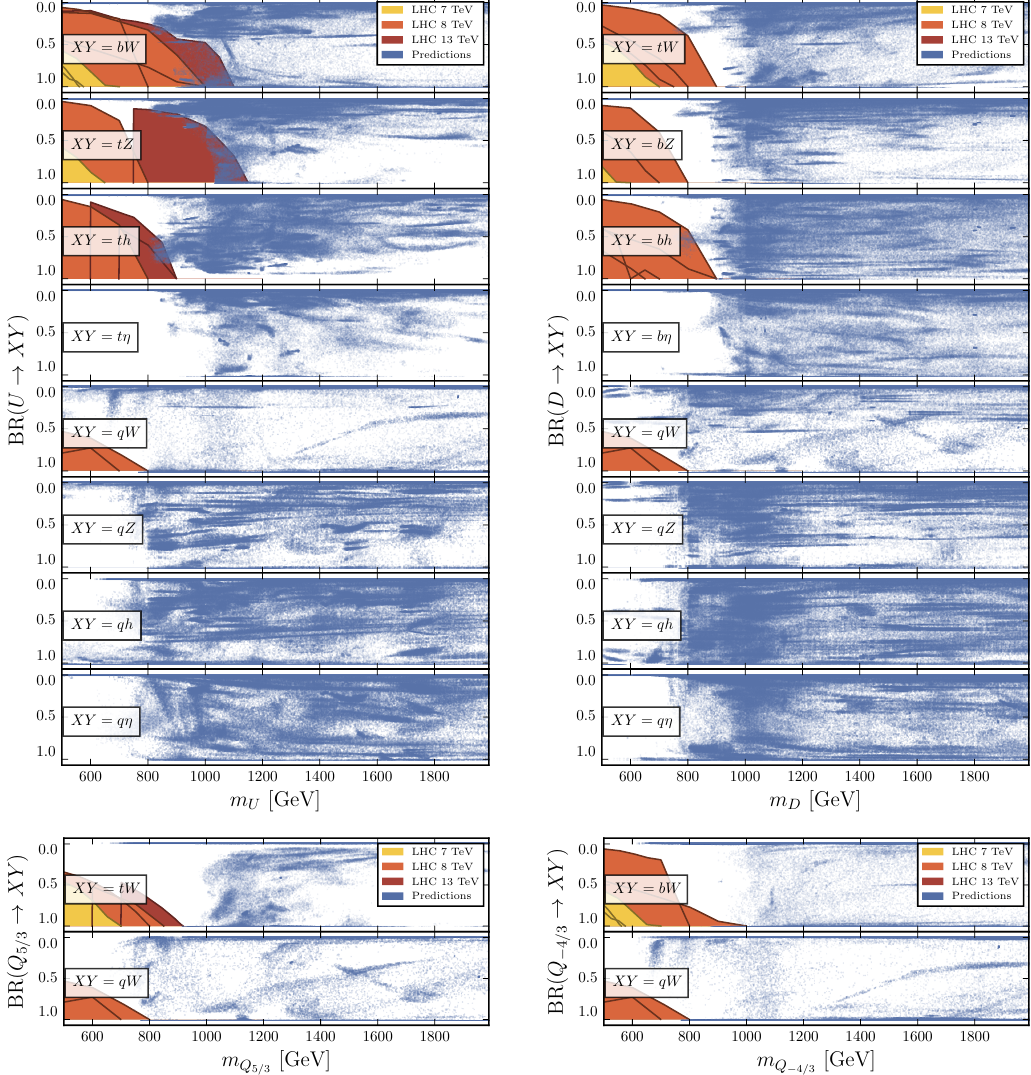
Figure 8 . Predictions for masses and branching ratios of up-type (upper-left), down-type (upper- right), charge 5 = 3 (lower-left) and charge 4 = 3 (lower-right) quark resonances. Experimental (cid:0) bounds from the LHC running at di(cid:11)erent center of mass energies are shown as coloured areas. The analyses that are included in the plots are listed in table